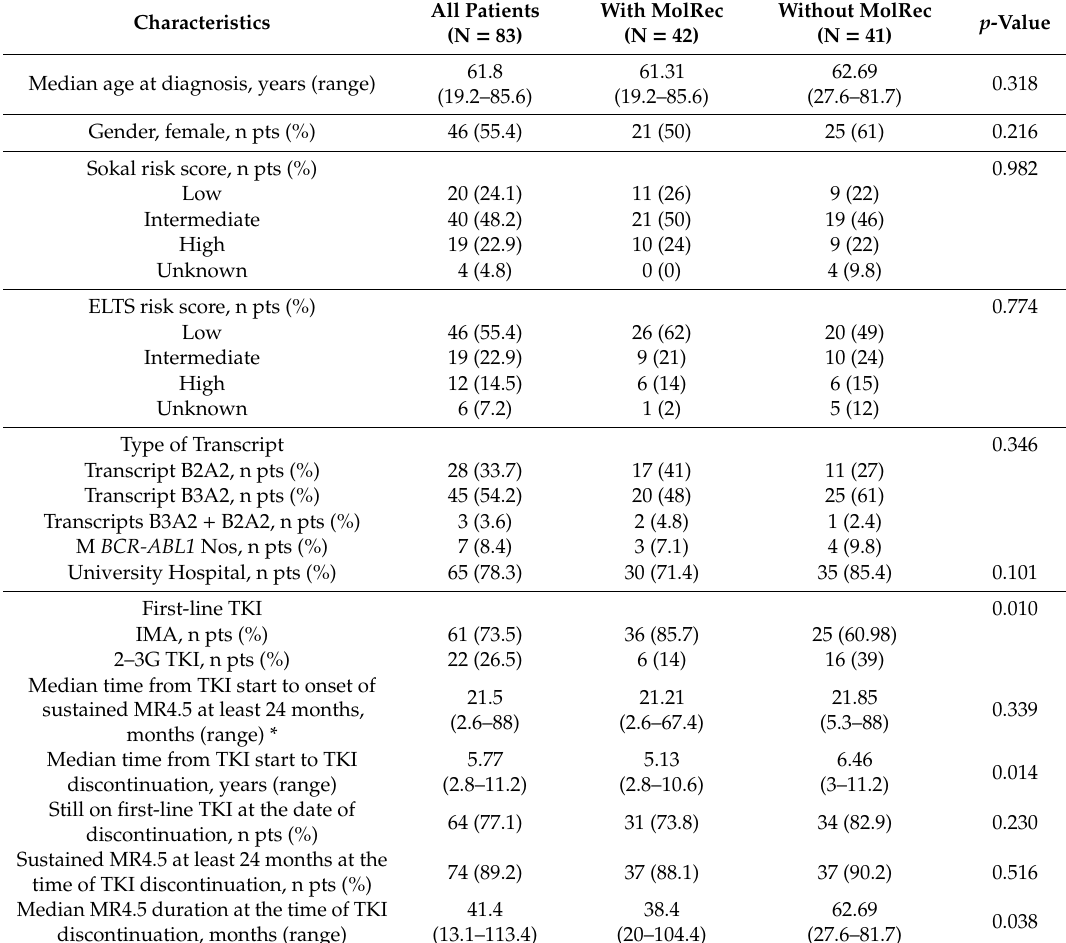
All Patients With MolRec Without MolRec (N = 83) (N = 42) (N = 41)